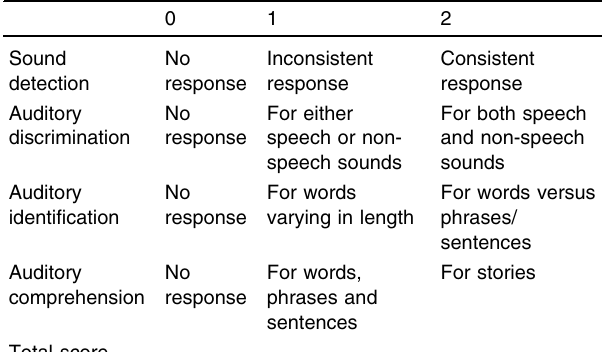
Table 1 The three- point scale of the child ’ s auditory